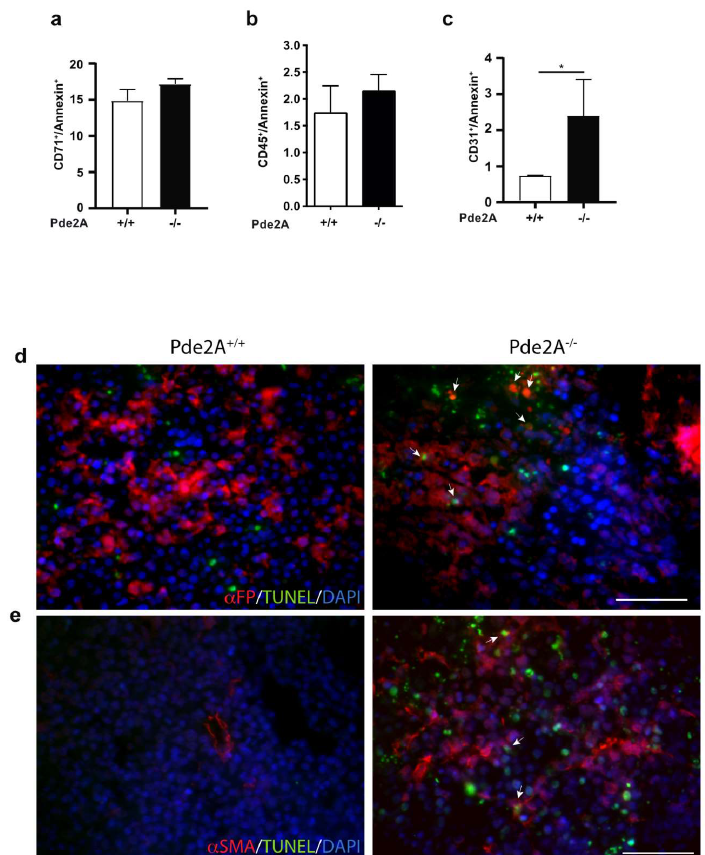
Figure 4. The niche is compromised in liver of PDE2A − / − embryos. ( a – c ) Flow cytometry analysis of liver cells isolated from E14.5 PDE2A +/+ and PDE2A − / − embryos, stained with Annexin-V and antibodies against CD71 ( a ), CD45 ( b ), CD31 ( c ) markers. Histogram showing the percentage of double stained cells reveals an increase of endothelial cell apoptosis in PDE2A − / − embryos. N = 3 embryos / genotype. * P < 0.05. ( d , e ) Immunofluorescence of E14.5 liver sections stained with α -FP and α -SMA antibodies (red) and with TUNEL assay. Nuclei were counterstained with DAPI (blue). Arrows indicate double stained cells. Scale bar 50 µm. N = 3 embryos/genotype.